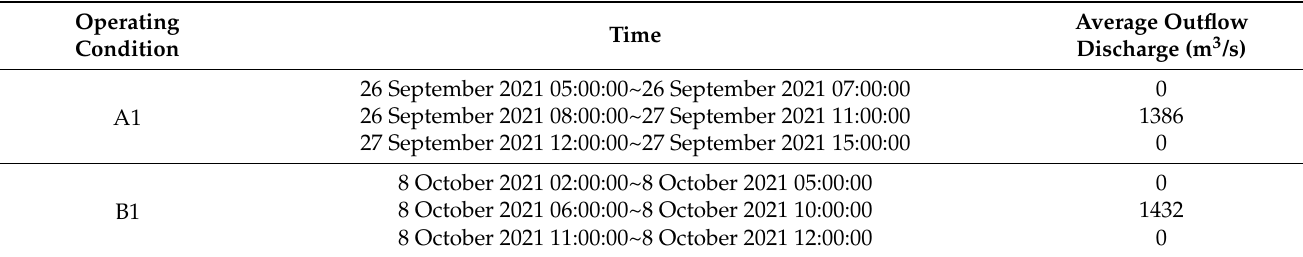
Table 7. Simulation results of plug-in model of reservoir outflow discharge calculation.